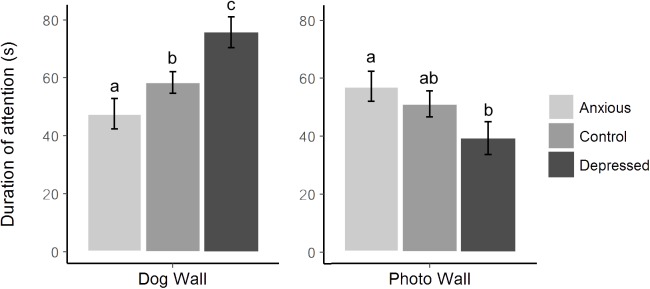
Mean ± SEM time spent looking toward the dog wall versus the photo wall for each treatment group during attention bias testing. Different letters represent significant differences between treatment groups within each section of the graph as determined using post hoc analyses.